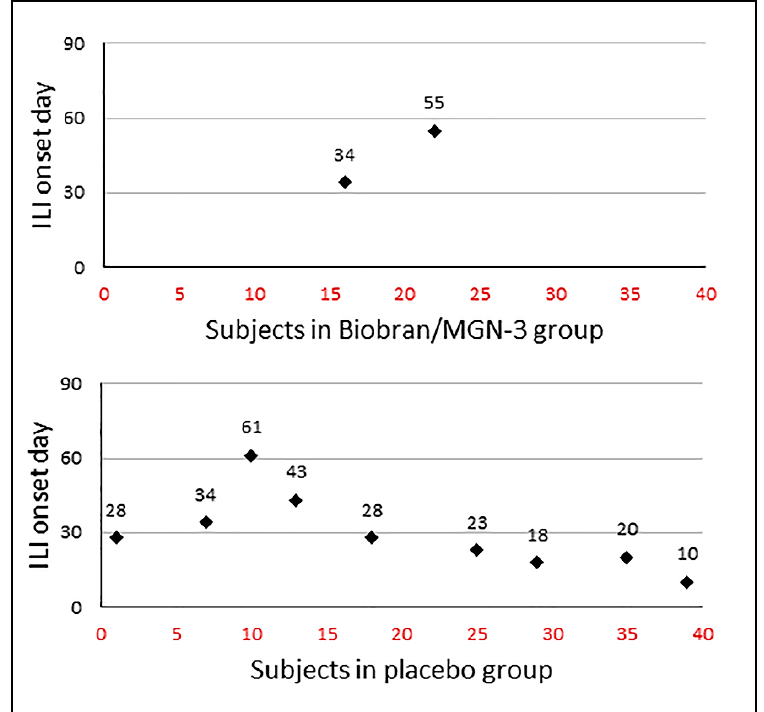
Figure 2. ILI incidence density distribution among the MGN-3/Biobran and placebo groups. The x-axis represents the patient number and y-axis represents the day of onset of ILI.